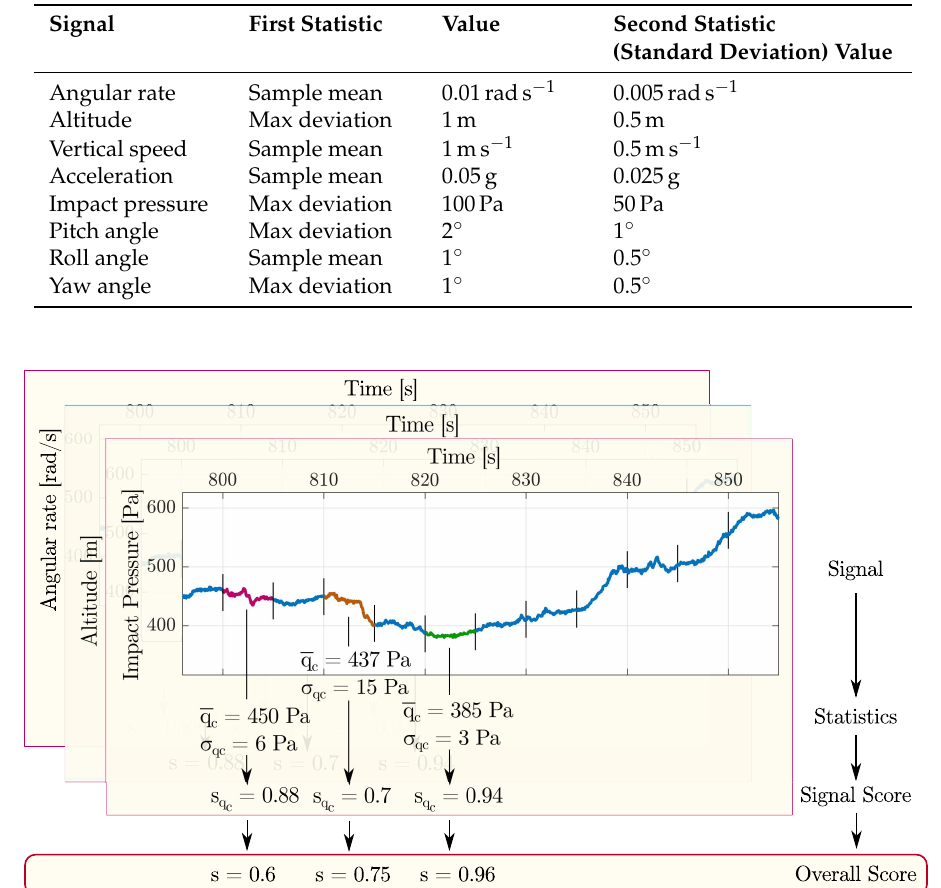
Figure 5. Schematic of the score assignment